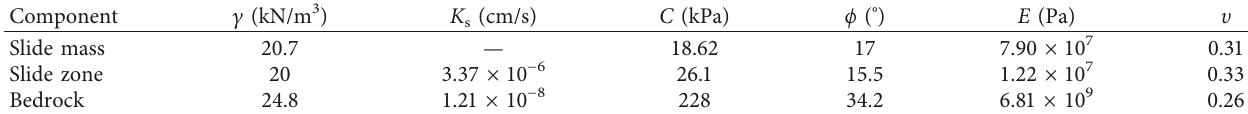
Table 3: Parameters of the calculation model.